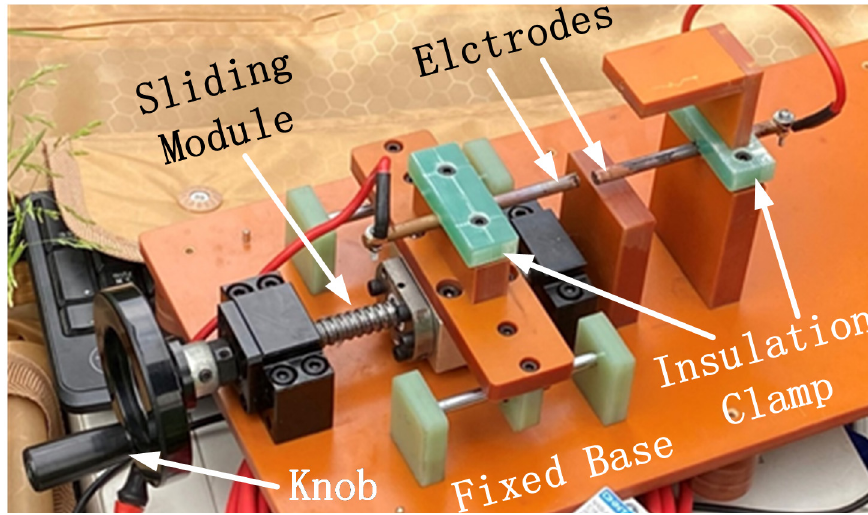
Figure 5. Photo of the arc generator.